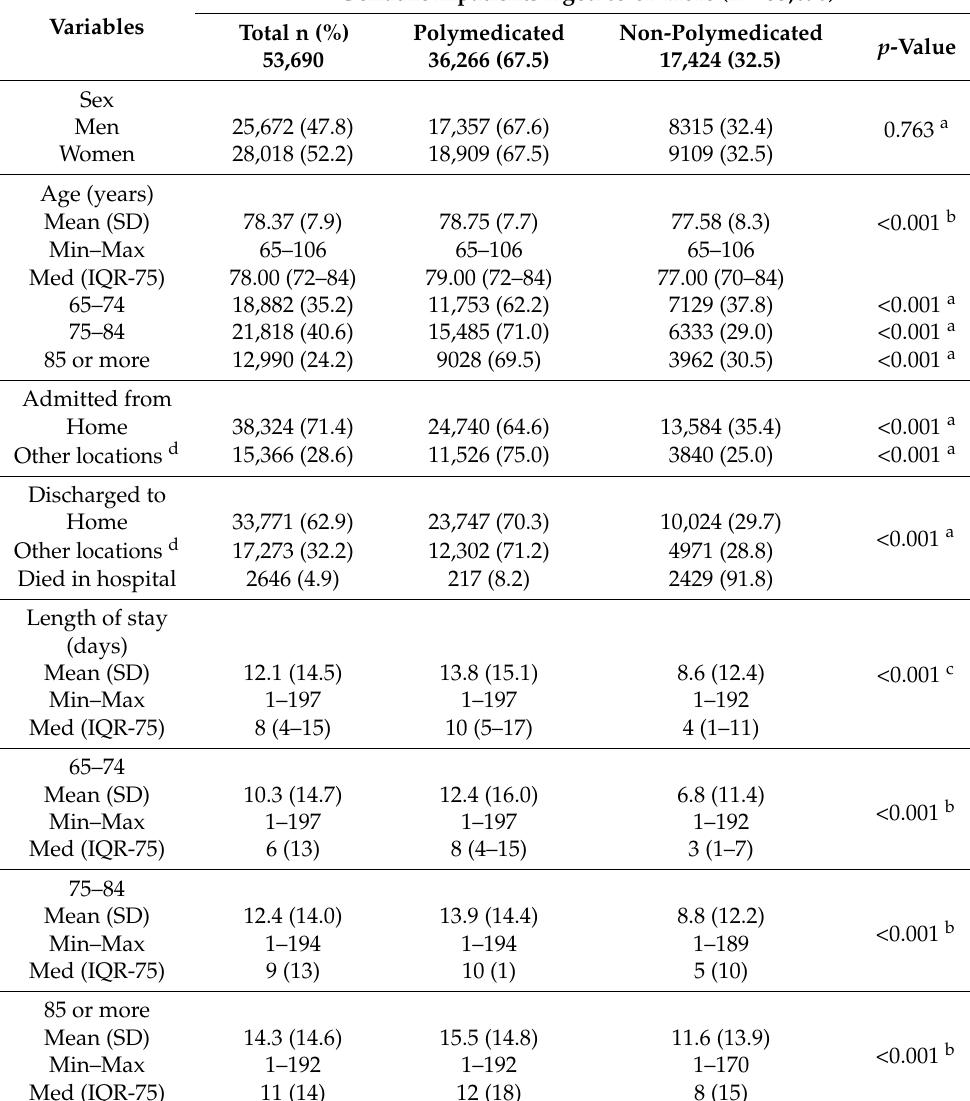
Table 1. Sociodemographic characteristics of the geriatric inpatients aged 65 or more (n = 53,690), and a comparison between those who were polymedicated (n = 36,266) and non-polymedicated (n =